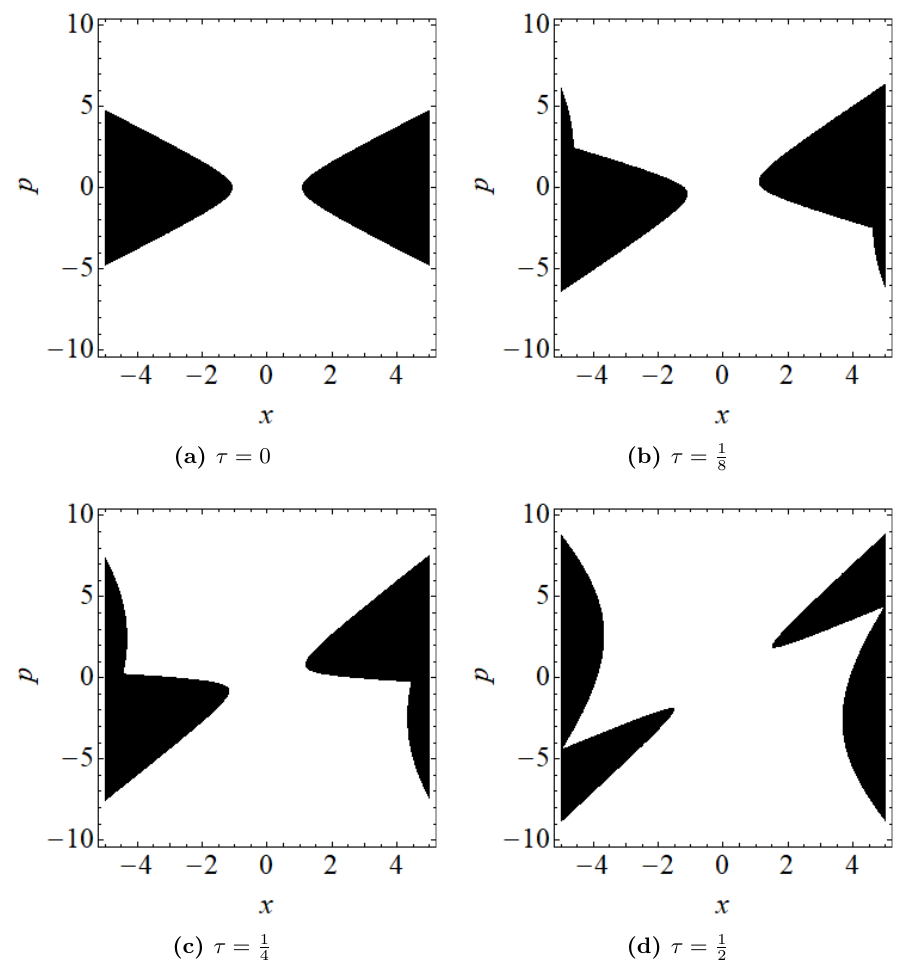
Figure 11. Time evolution of phase space density u ( x; p; (cid:28) ) for the potential with a cuto(cid:11) at x = (cid:6) l= 2 after abrupt quench. Choose ! 0 = 1